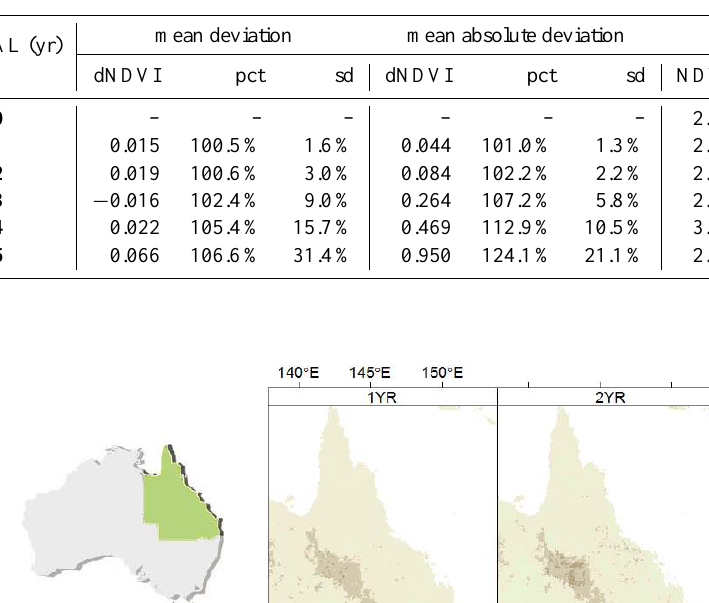
Table 2. The MTUP effect for a sample of 1000 AVHHR pixels and aggeregation levels (AL) of 1 to 5yr. Detected changes in NDVI (dNDVIagg) were compared to those found using seasonally adjusted data (dNDVIref) and listed as dNDVIagg–dNDVIref (dNDVI), dND- VIagg/dNDVIref (pct) and square root of the sample variation of pct (sd). The last columns list the detected changes in NDVI for the pixel in Fig. 3. In all cases, slopes were significant ( p < 0 . 05). NDVI values were multiplied by 100 for numerical convenience.